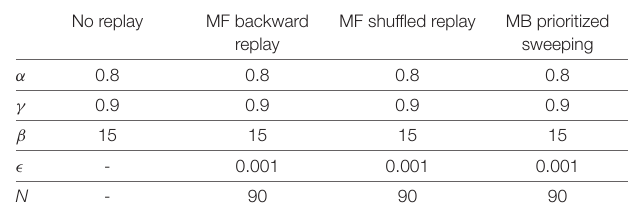
TABLE 2 | Algorithm parameters are used to generate the results in this